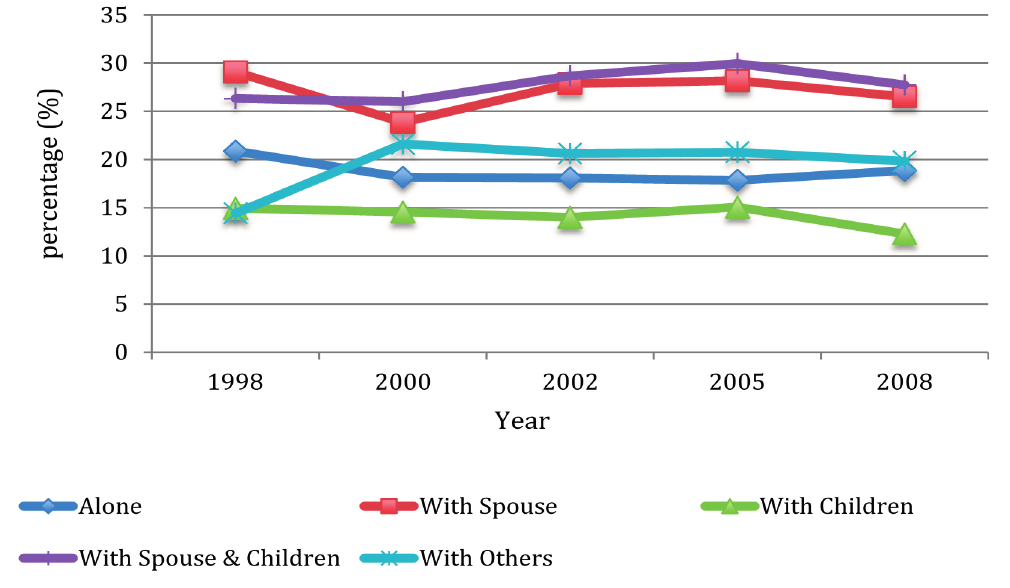
Figure 1. Percentage of smoking by wave and by living arrangement.